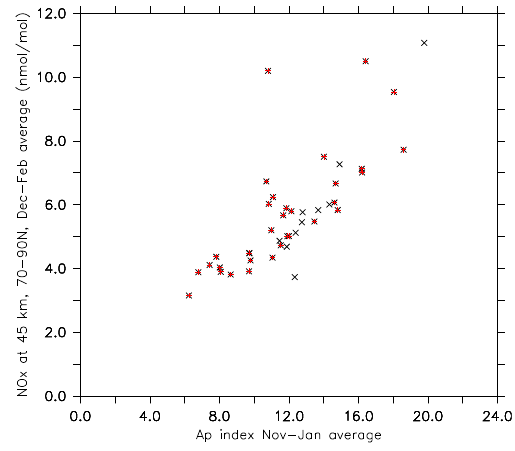
Fig. 3. Southern Hemisphere JJA temperature difference (K) be- tween years of high and low geomagnetic activity (see Table 1) from the transient simulation. Red/blue colours indicate positive/negative differences.